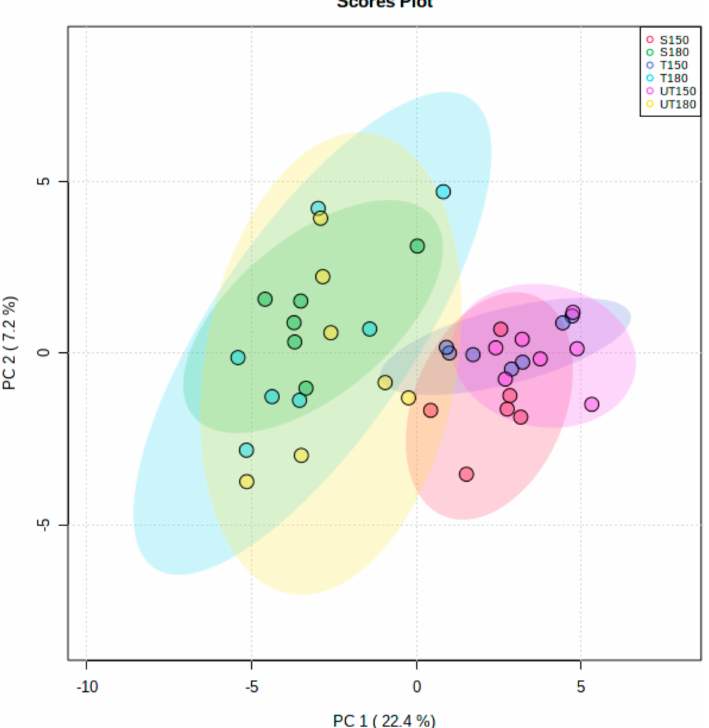
Figure 1. Principal component analysis (PCA) scores plot of component area normalized data of VOC profiles. Red and green dots indicate VOC profiles obtained for sow fat heated at 150 ◦ C ( n = 6) and 180 ◦ C ( n = 6), dark blue and light blue represent VOC profiles for tainted boar fat heated at 150 ◦ C ( n = 7) and 180 ◦ C ( n = 7); lastly, pink and yellow dots represent untainted fats at 150 ◦ C ( n = 7) and 180 ◦ C ( n = 7)